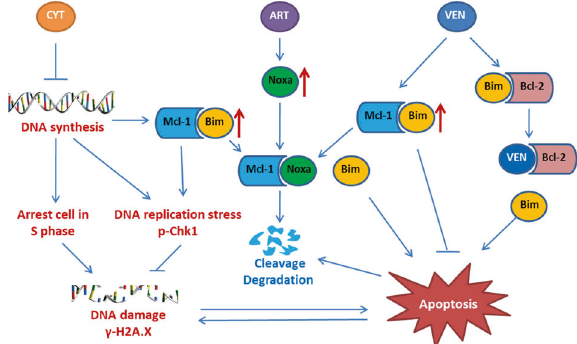
Fig. 8 Mechanistic cascade of cytarabine (CYT), venetoclax (VEN), and artesunate (ART) triple combination to induce augmented death of AML units were visualized using an inverted microscope, and the number of colonies containing >50 cells was counted. Colonies were stained with MTT solution and photographed.